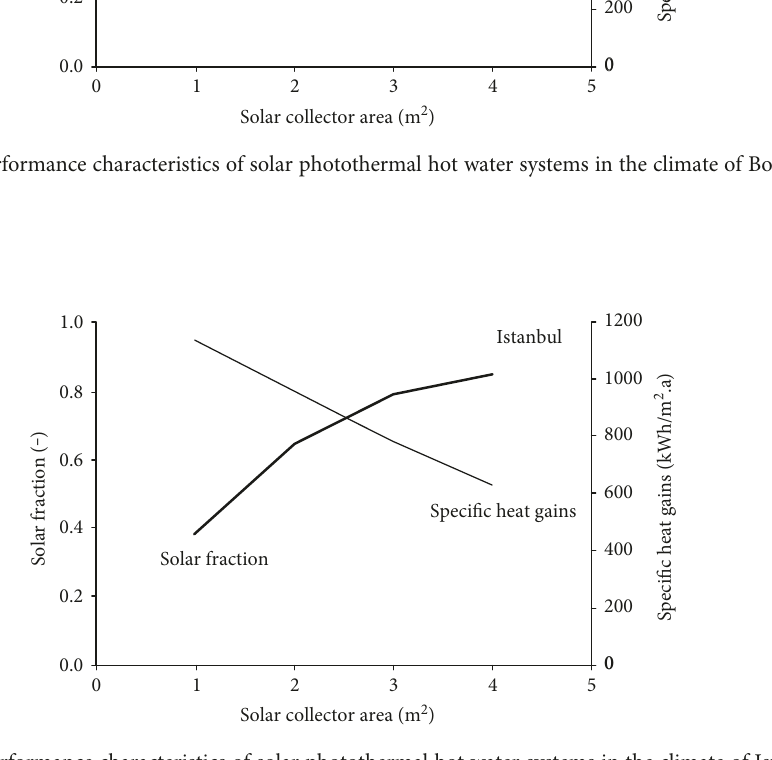
Figure 11: Performance characteristics of solar photothermal hot water systems in the climate of